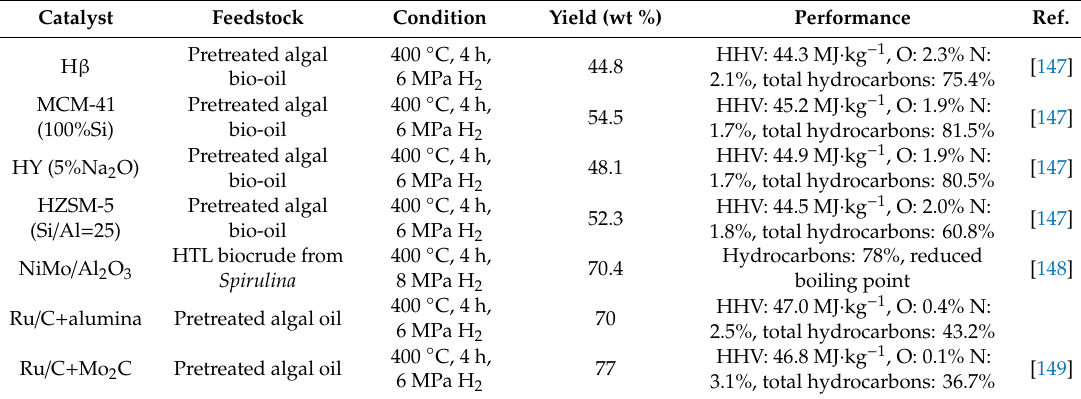
Table 7. Catalytic upgrading of biocrude oil from thermochemical conversion. Catalyst